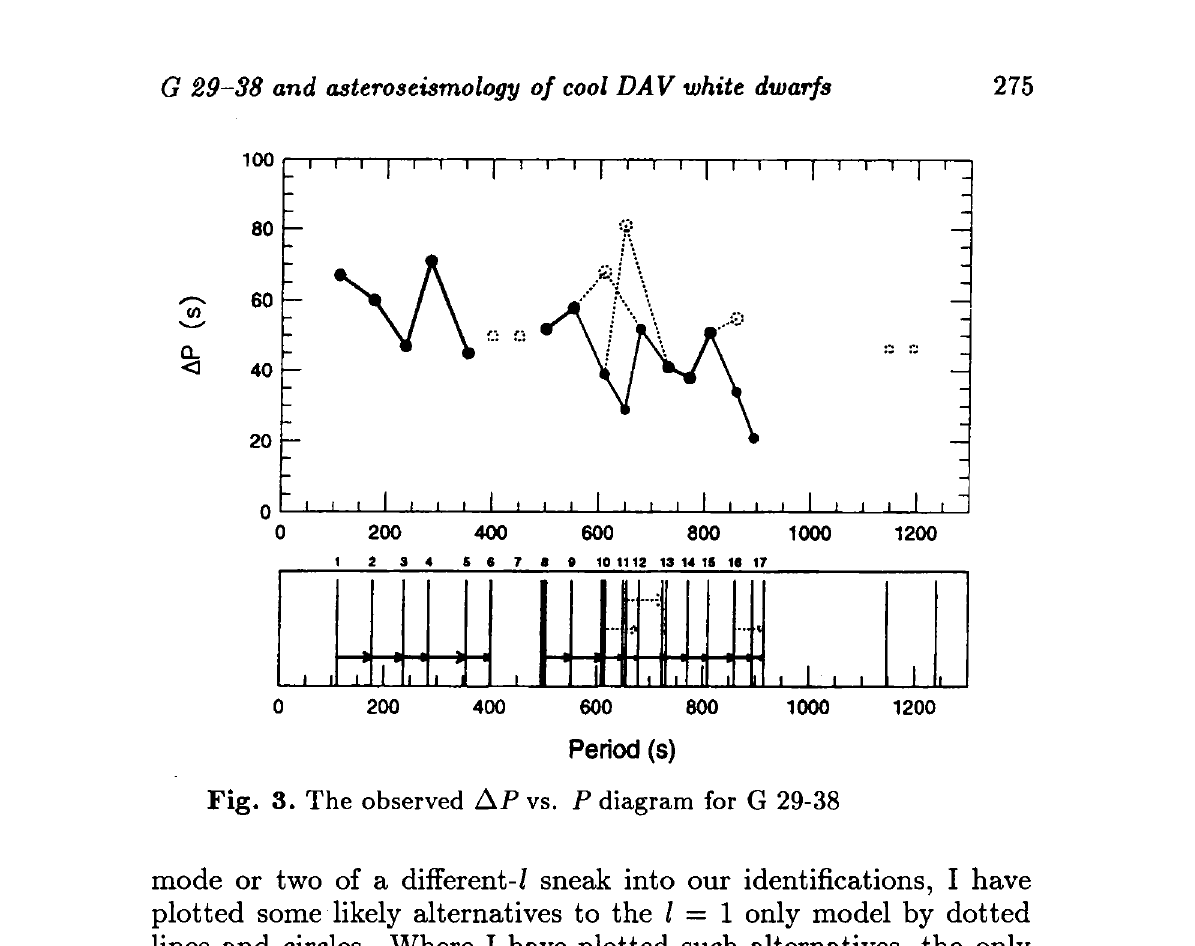
Fig. 3. The observed A P vs. P diagram for G 29-38 mode or two of a different-/ sneak into our identifications, I have plotted some likely alternatives to the I = 1 only model by dotted lines and circles. Where I have plotted such alternatives, the only 1 = 1 interpretation is plotted with thinner lines and slightly smaller filled circles. The bottom panel of the plot is an enlarged plot of the sum row of Fig. 2 with arrows showing which modes were used to calculate the differences shown above it. The line type of each conforms with the convention used in the first panel. Above this plot are k assignments at / =